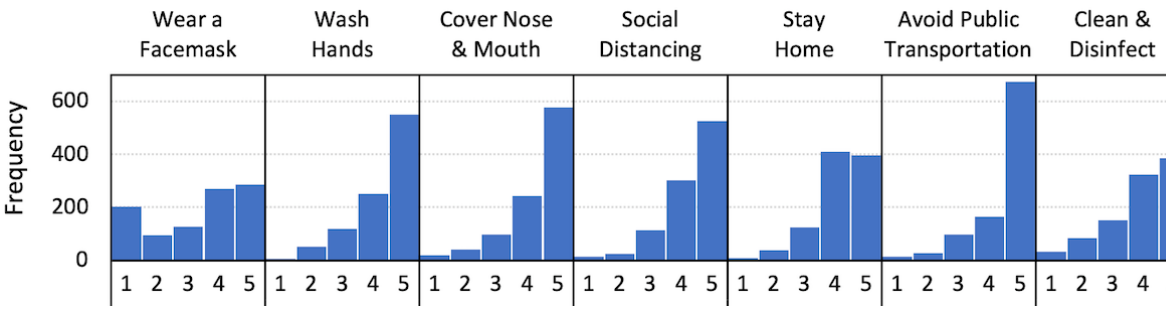
Figure 1. Response distributions of the self-reported preventative behaviors. Responses were coded from 1 (Never) to 5